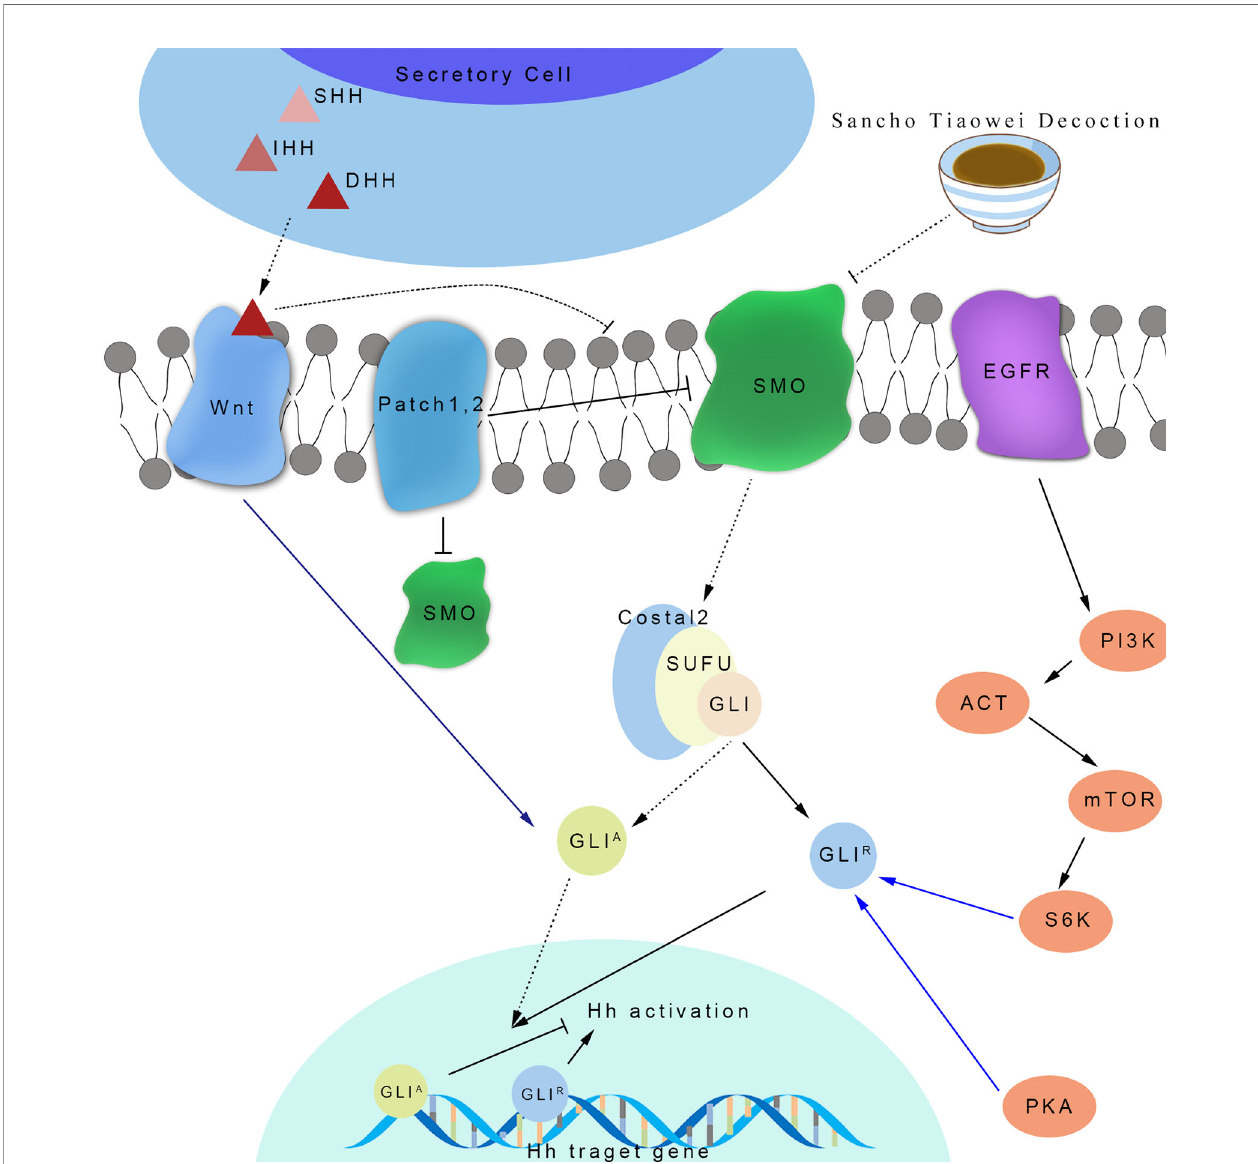
FIGURE 9 | The mechanism of SCTWD in the treatment of PLGC through hedgehog signaling